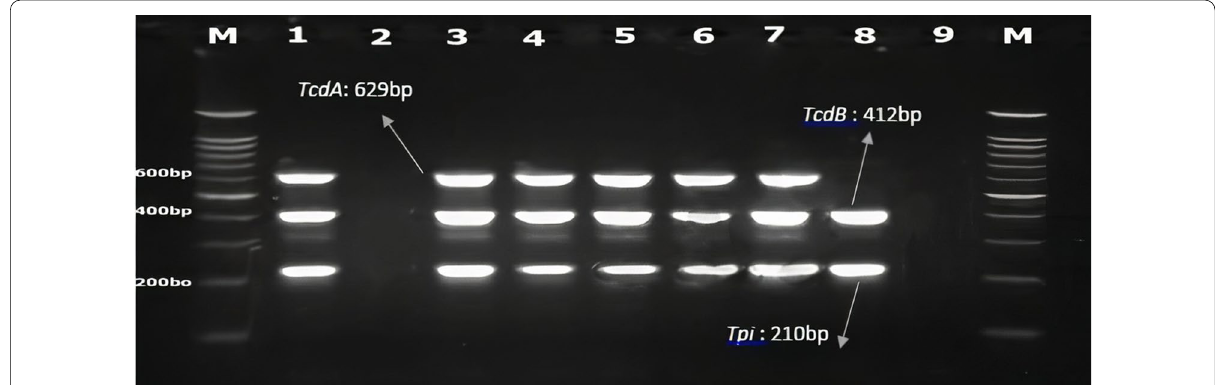
Fig. 1 Multiplex-PCR for tpi . tcdA and tcdB genes. Lane 1: Control positive: Clostridioides difficile ATCC9689; Lane 2: Control negative: distilled water;